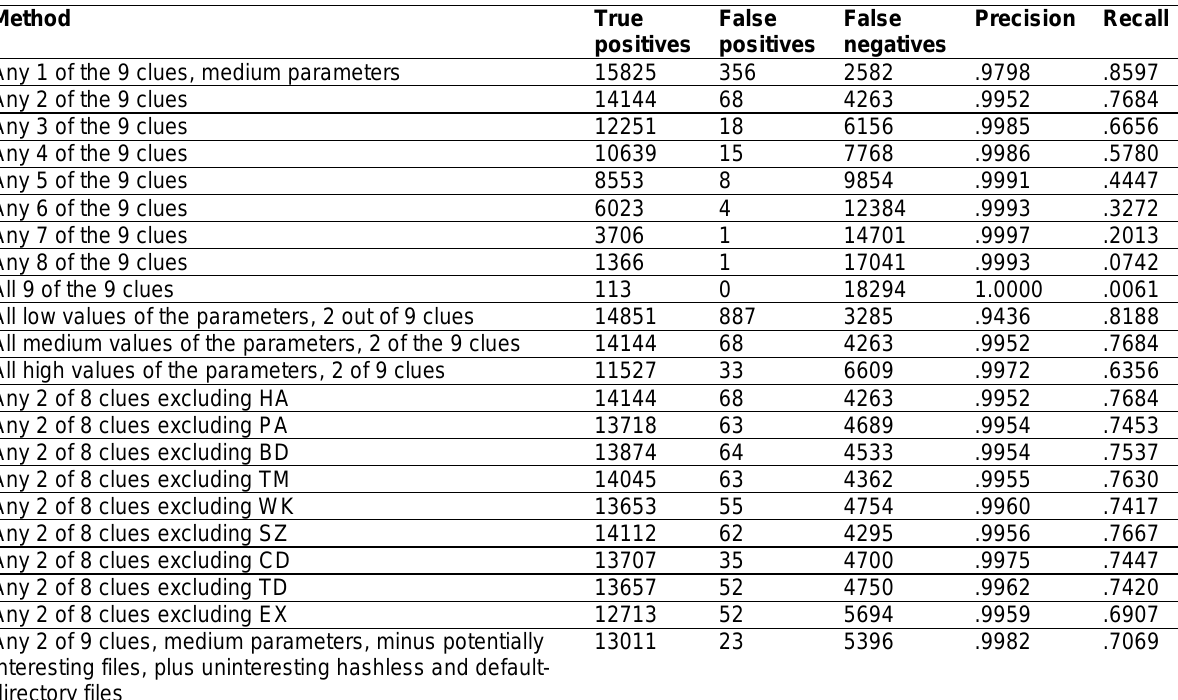
Table 6. Additional effects of parameter variation on the accuracy of identifying uninteresting